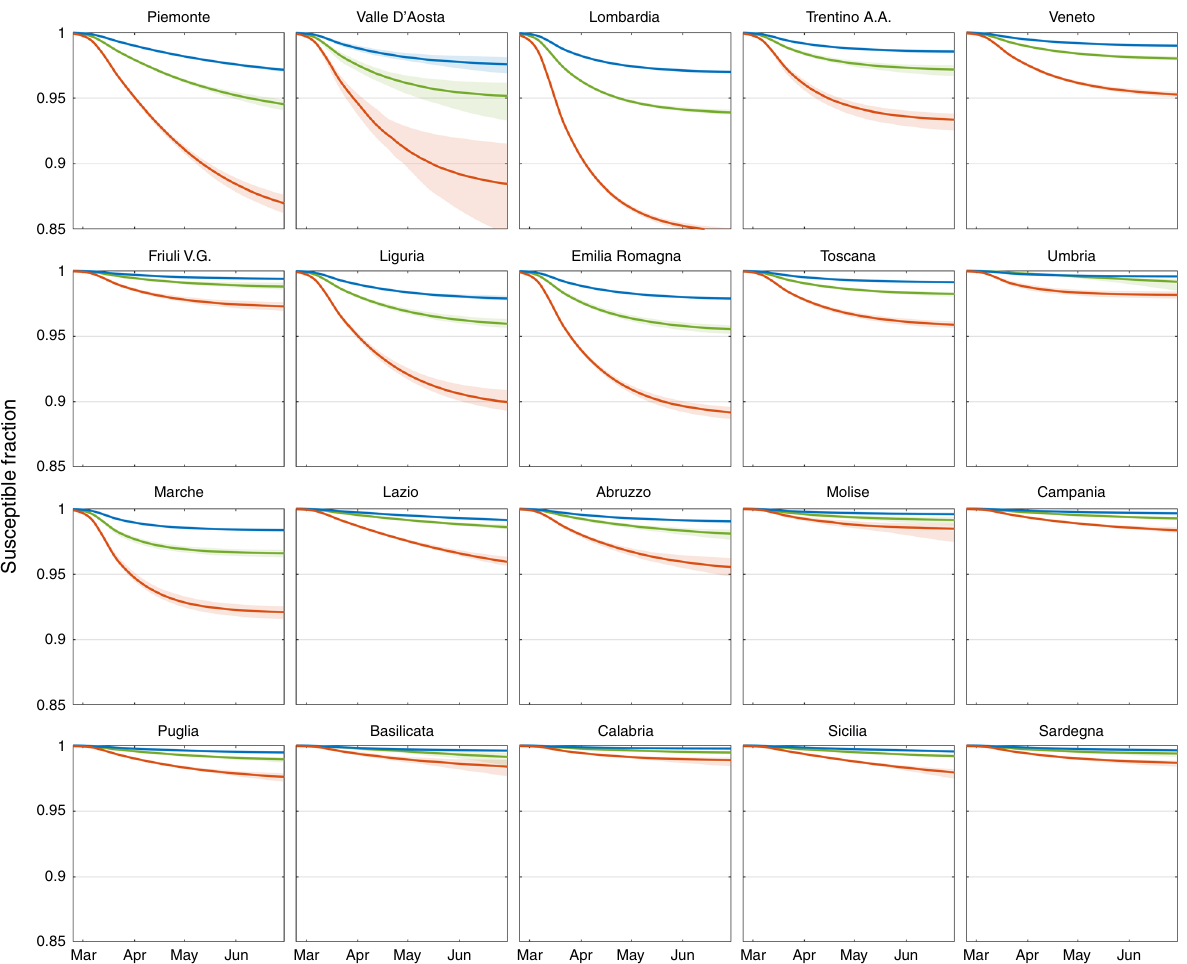
Fig. 3 Mapping possible acquired immunity in Italy. Temporal dynamics of the fraction of susceptible individuals in each region, estimated by considering three possible percentages of heavy symptomatic infections: σ = 50% (blue curve), 25% (green curve), and 10% (red curve). Thick solid curves refer to medians values, whereas shaded areas indicate the 95% con fi dence percentage of E and P individuals to be isolated (right axis of Fig. 4) remains instead constant.